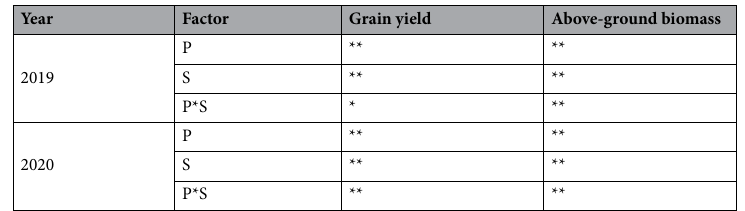
Table 4. ANOVA of effects of planting patterns, super absorbent polymers on grain yield and above-ground biomass of oat in 2019–2020. **Significant at 0.01 level, * significant at 0.05 level. P and S represent planting pattern and water absorbing amendment.